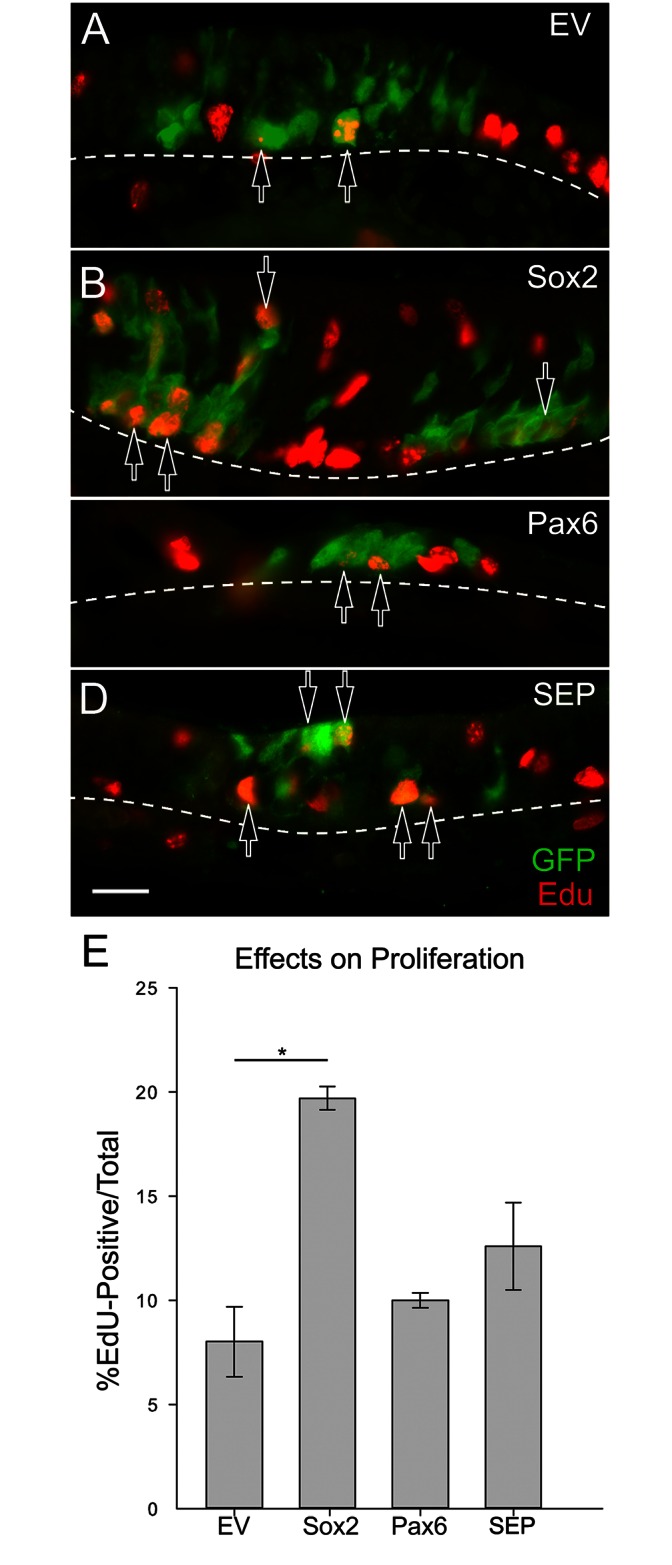
Sox2 transduction increases the number of cells proliferating early on in the regeneration process, compared to control.(A-D) Proliferation of transduced cells was assessed, across viral constructs at 8 days post-infection by labeling with GFP and EdU (to identify cells in S-phase at the time of euthanasia). Hollow arrows indicate examples of GFP (+)/EdU (+) cells. Note the large number of double-labeled cells with Sox2 transduction (B). Dashed lines mark the basal lamina, and the scale bar in (D) corresponds to 20 μm and applies to all of the images. (E) The mean number of EdU (+) cells is plotted as a percentage of the total number of GFP (+) cells (percentages were derived from count data justifying arcsin-transformation to allow for multiple testing by Kruskal-Wallis ANOVA, with Dunn’s method for pairwise comparisons, * p < 0.05).